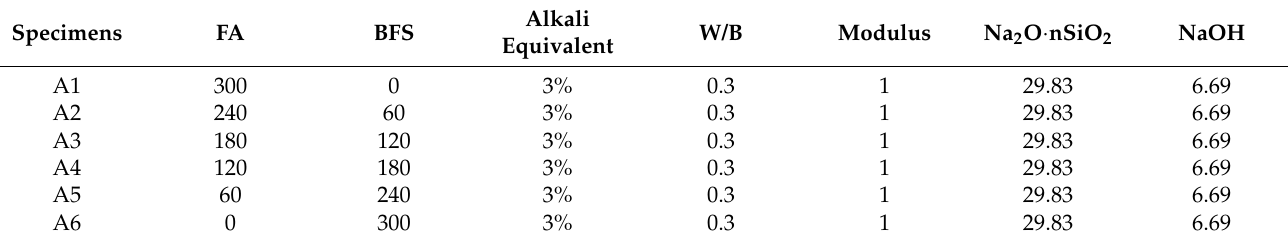
Table 3. The mixing proportions (kg/m 3